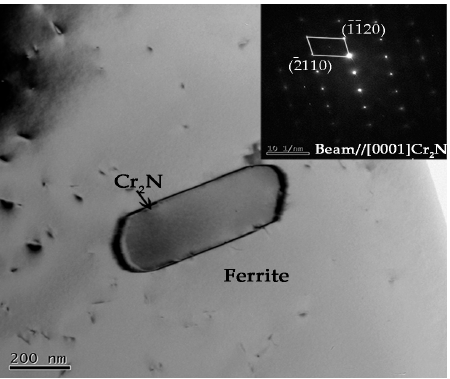
Figure 9. General bright field TEM micrograph of rod-like chromium nitride precipitated in ferrite matrix and the corresponding diffraction patterns.